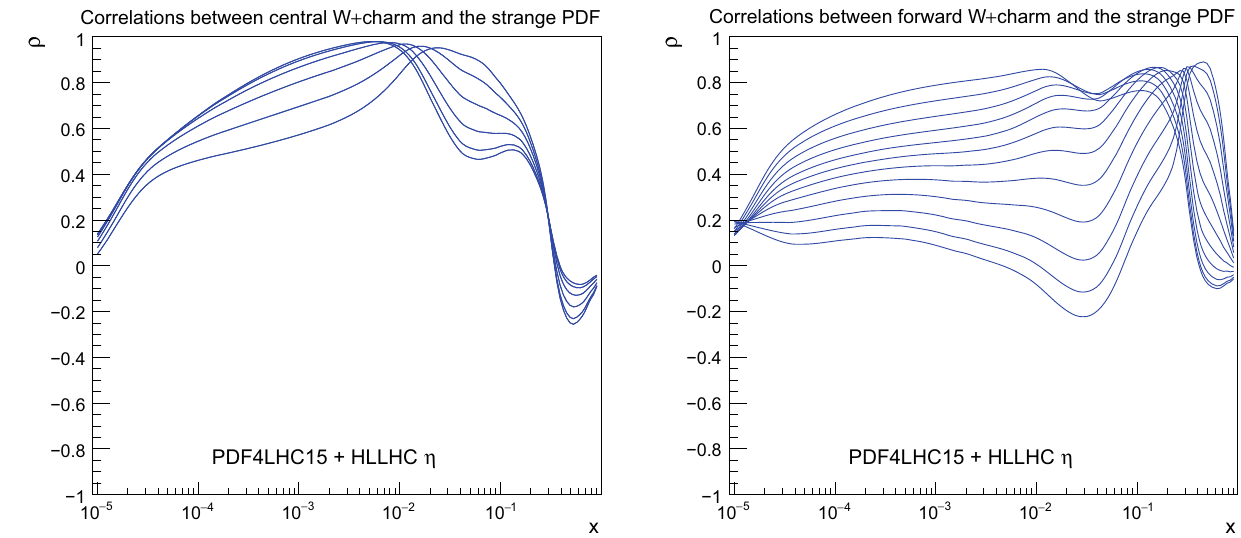
−1−0.8−0.6−0.4−0.200.20.40.60.81 η PDF4LHC15 + HLLHC Fig. 12 As in Fig. 4, now for the correlation coefficient between the strange PDF and the lepton rapidity distributions in W +charm production pseudo–data in the central rapidity region (left) and in the forward region (right plot) Fig. 13 As in Fig. 5, now for W +charm production in the central (left dominant correlated source of uncertainty, namely the 5% normaliza- plot) and forward (right plot) rapidity regions. In the right plot only tion the statistical errors are shown, while the data have been shifted by the